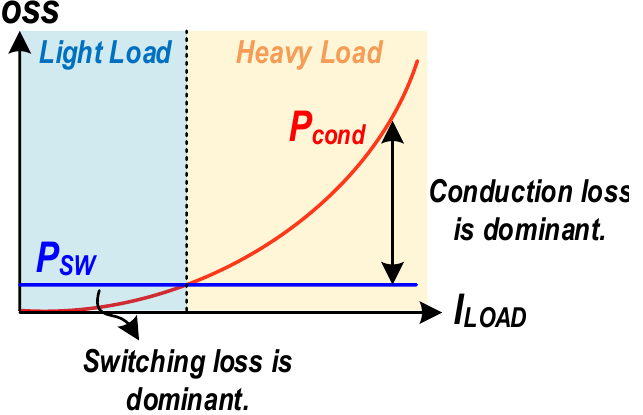
Figure 1. Graph of the switching loss and conduction loss in different conditions.